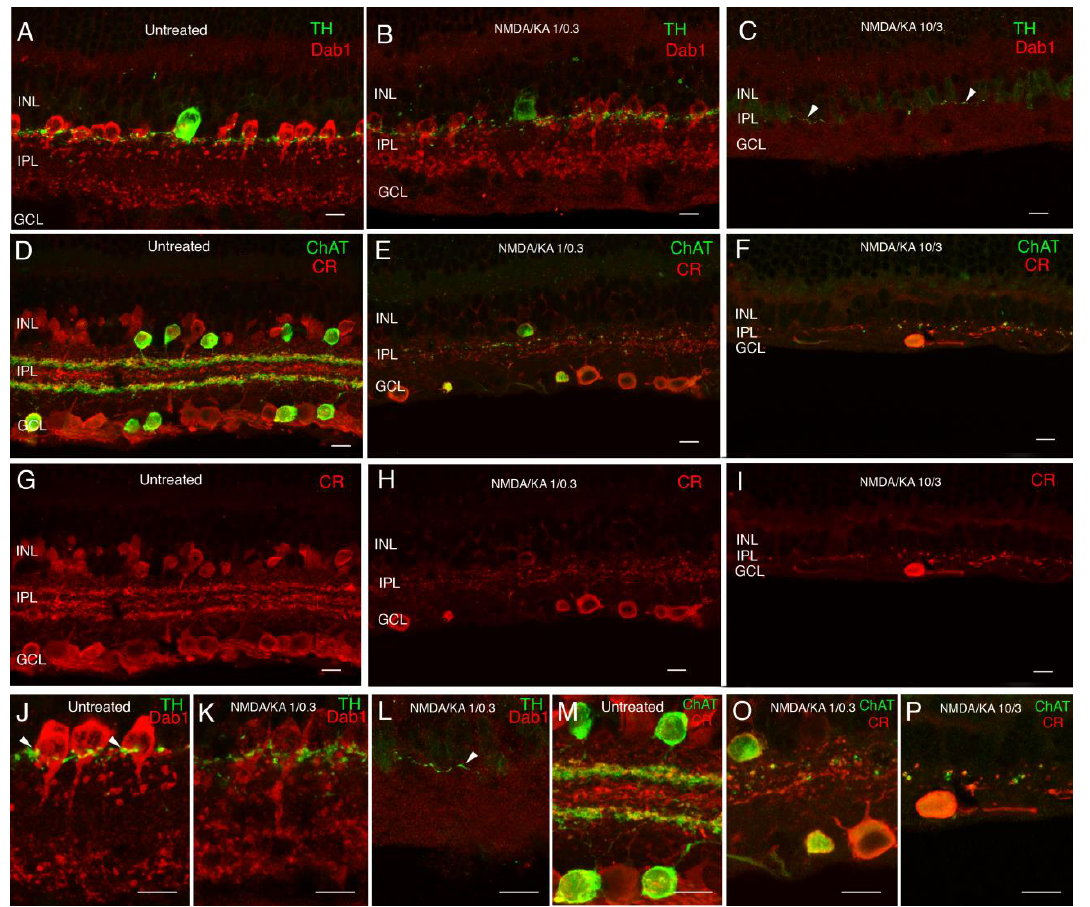
Figure 3. Response of amacrine cells to excitotoxicity. Double immunolabeling with antibodies against tyrosine hydroxylase (TH) and Dab1 ( A – C , J – L ). Tyrosine hydroxylase shows the dopaminergic amacrine cells and their dendritic plexus in the S1 stratum in the IPL ( A , J , green). Dab1 shows the AII amacrine cells, whose typical lobular appendages are mainly in the OFF layer and their dendritic terminals in the ON layer ( A , J red). Synaptic contacts from dopaminergic cells around the cell bodies of AII amacrine cells can be observed ( J arrowheads). A decrease in TH and Dab1 immunoreactivity intensity is found in response to the 1/0.3 concentration of NMDA/KA. The morphology of AII amacrine cells looks disorganized, but the synaptic contacts with the dopaminergic cells still remain ( B , K ). At the NMDA/KA 10/3 dose, AII amacrine cells cannot be identified and only a few dendrites of dopaminergic cells can be observed in the S1 stratum of the IPL ( C , L arrowhead). Double immunolabeling with antibodies against calretinin and choline acetyltransferase ( D – I , M – P ). Calretinin immunoreactivity labels several types of amacrine cells and ganglion cells with three typical plexuses of dendrite stratification in the IPL ( D , G , M red). ChAT immunoreactivity is found in starburst amacrine cells, whose cell bodies are located in the INL and in the ganglion cell layer, and their dendrites stratify in two specular plexuses in the ON and OFF layers of the IPL ( D , M green). At the 1/0.3 concentration of NMDA/KA, calretinin immunoreactive amacrine cells cannot be identified, and only a few ChAT amacrine cells and some CR ganglion cells remain ( E , H , O ). Both plexuses experience a big disruption and disorganization. At a 10/3 concentration, only some spots of ChAT and CR immunoreactivity can be observed in the IPL, accompanying IPL degeneration ( F , I , P ). INL—inner nuclear layer; IPL—inner plexiform layer; GCL—ganglion cell layer. Scale bar of 10 µ